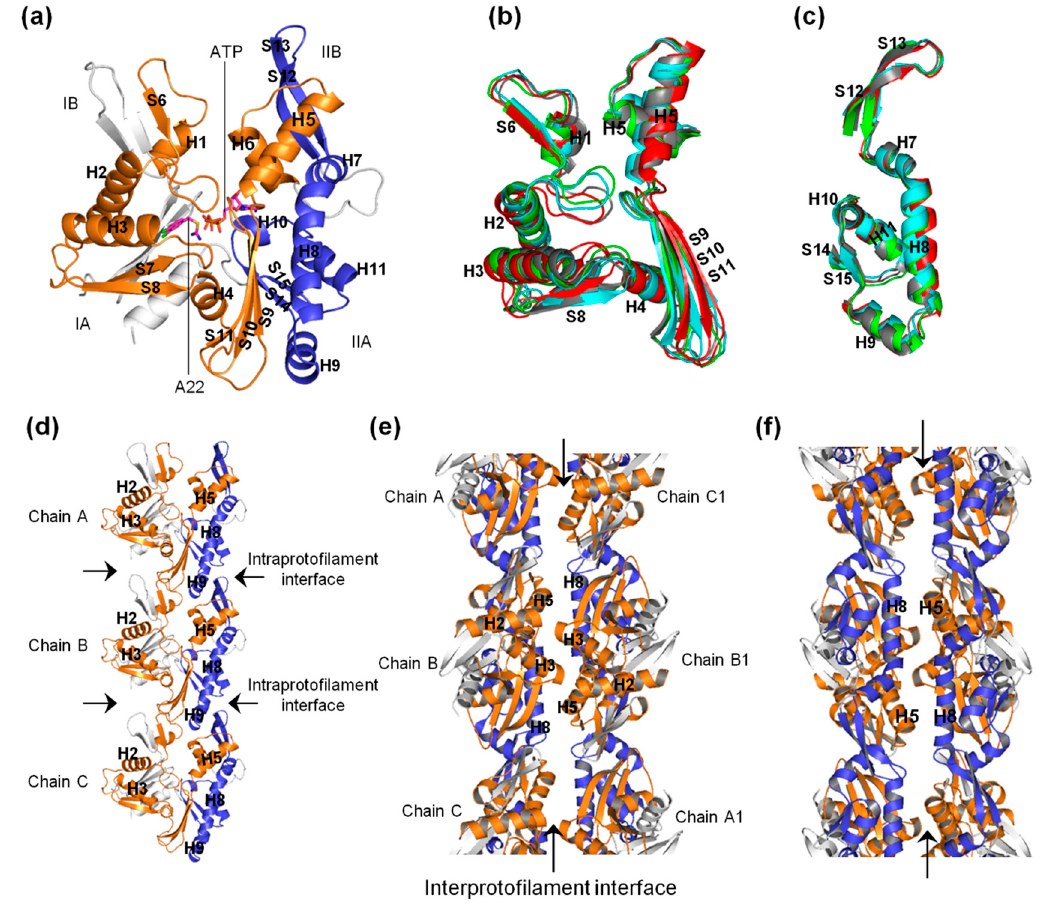
Figure 7. Possible roles of the Ile55-Ile219 (orange) and Ser232-Val316 (blue) segments in MreB polymerization. ( a ) Monomeric MreB structure showing the secondary structural elements making up the Ile55-Ile219 and Ser232-Val316 segments. ATP and A22 are also shown. ( b ) Superimposed structures of the Ile55-Ile219 segments from chain B of the crystal (gray), apo (cyan), ATP+ (red), and ATP-A22+ (green) filaments. ( c ) Superimposed structures of the Ser232-Val316 segments from chain B of the crystal (gray), apo (cyan), ATP+ (red), and ATP-A22+ (green) filaments. ( d ) Single protofilament of MreB illustrating the roles of the Ile55-Ile219 and Ser232-Val316 segments at the intraprotofilament interfaces. ( e – f ) Double protofilaments of MreB illustrating the roles of the Ile55-Ile219 and Ser232-Val316 segments at the interprotofilament interface.